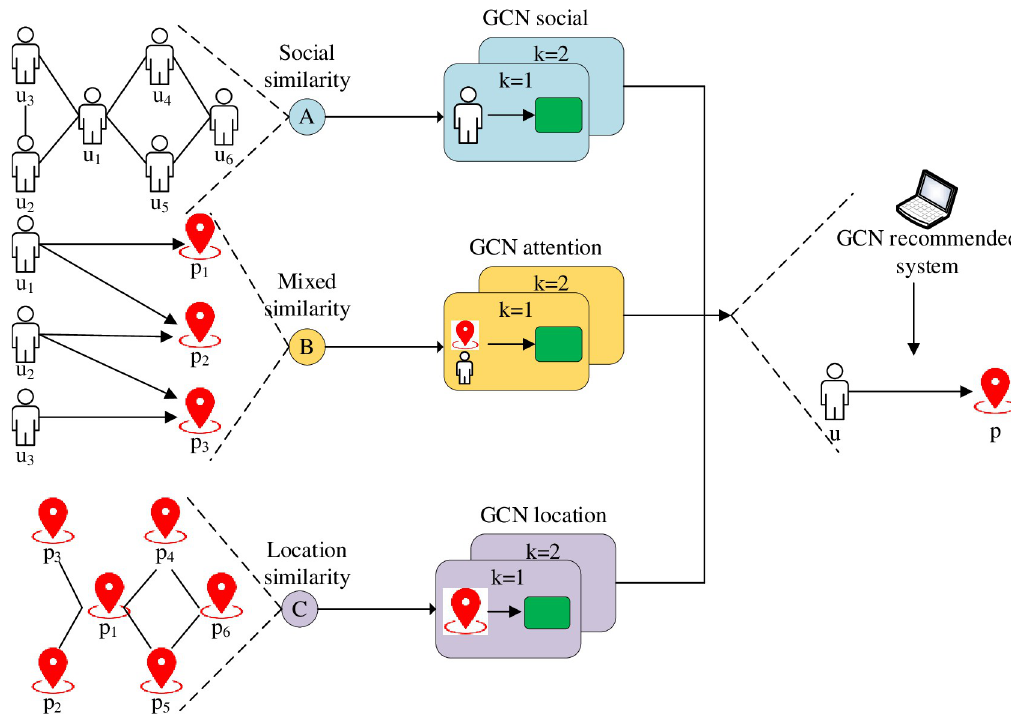
Fig 3. GCNN-based feature extraction